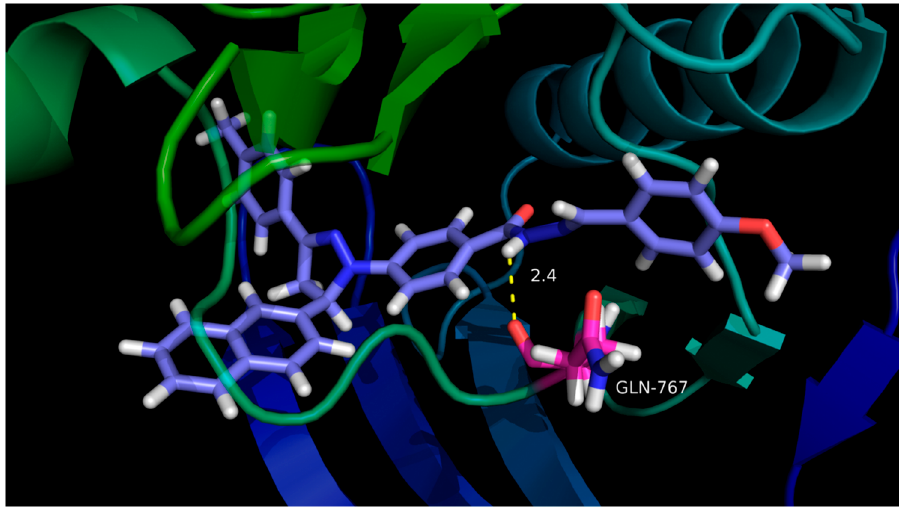
Figure 5. Molecular docking 3D modeling of compound H20 with the EGFR enzyme: for clarity, only interacting residues are displayed.